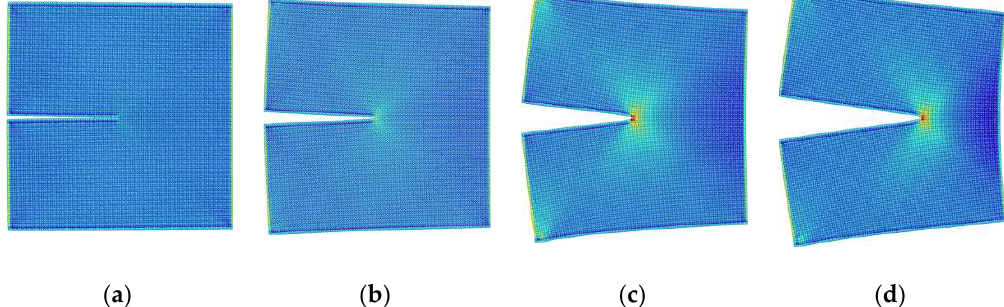
Figure 3. Snapshots of the atomistic configuration corresponding to different stages of the Cu nanoplate with a crack length of 25 c . Atoms are colored according to the σ 22 component of the atomic stress, with blue indicatinglow stress and red representing high stress. ( a ) Initial relaxed state before applying tensile displacement. ( b ) The linear stage. ( c ) The nonlinear stage. ( d ) The declining stage.